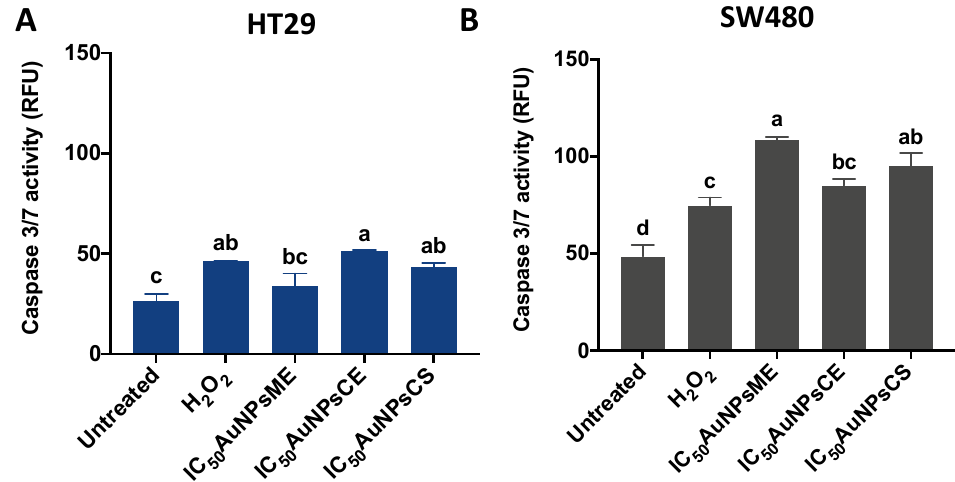
Figure 8. Evaluation of caspase 3/7 activity after treatment of HT29 ( A , B ) SW480 cells with the half inhibitory concentrations (IC 50 ) of AuNPsME, AuNPsCE, and AuNPsCS. Different letters (a, b, c, d) in Figure 8A,B indicate significant differences ( p < 0.05) by Tukey-Kramer’s test. AuNPsCE: Gold nanoparticles synthesized with a castor bean (R. communis) leaves extract; AuNPsCS: Gold nano- particles produced by chemical synthesis; AuNPsME: Gold nanoparticles synthesized with common mullein (V. thapsus) flowers ethanolic extract; RFU: Relative fluorescence units. Hydrogen peroxide (H 2 O 2 )-treated cells (30 mM) were used as a positive control. Untreated cells (DMEM + 0.5% ASB) were used as a negative control.